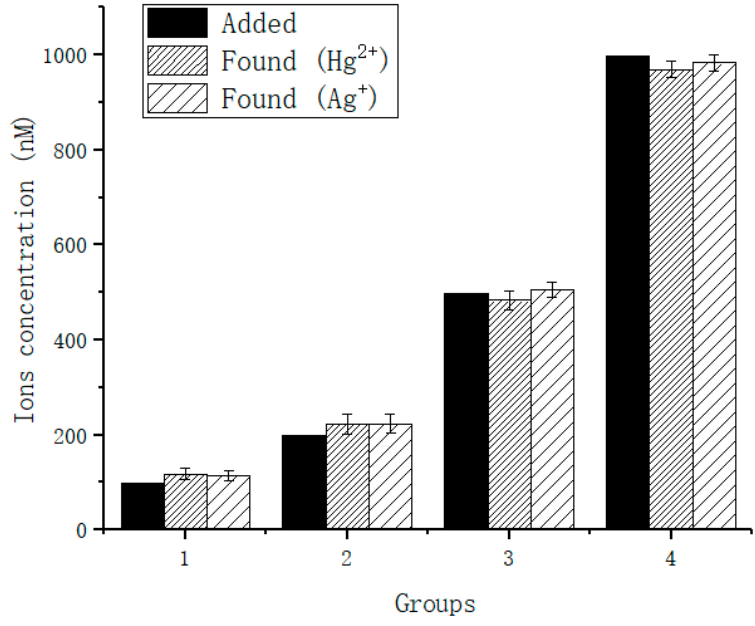
Figure 8. Detection of Hg 2+ and Ag + in actual samples.